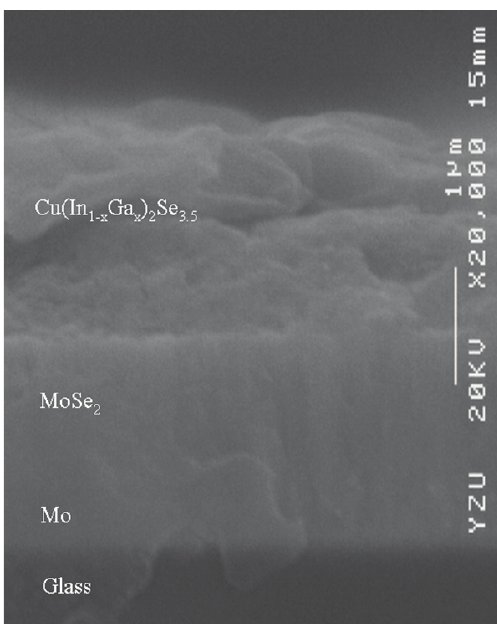
Figure 7: Cross-sectional SEM photographs of CIGS film